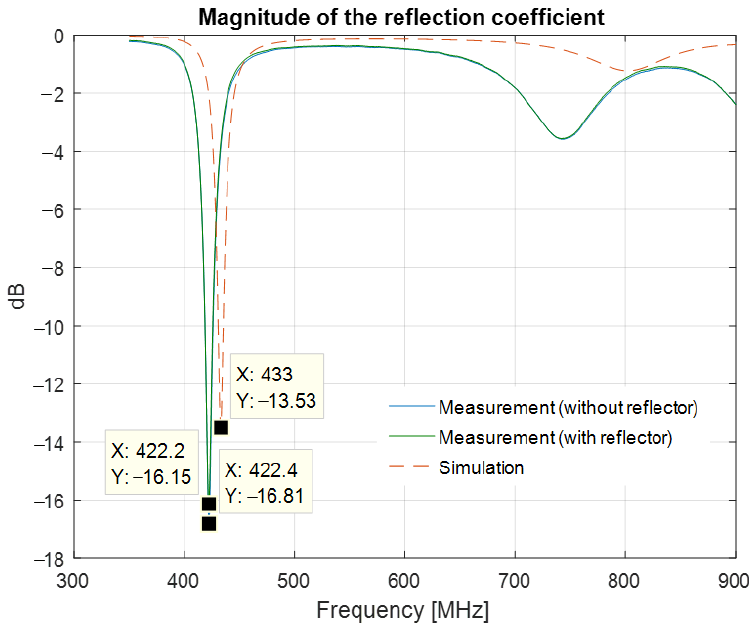
Figure 25. Magnitude of the reflection coefficient: measured and simulated results.